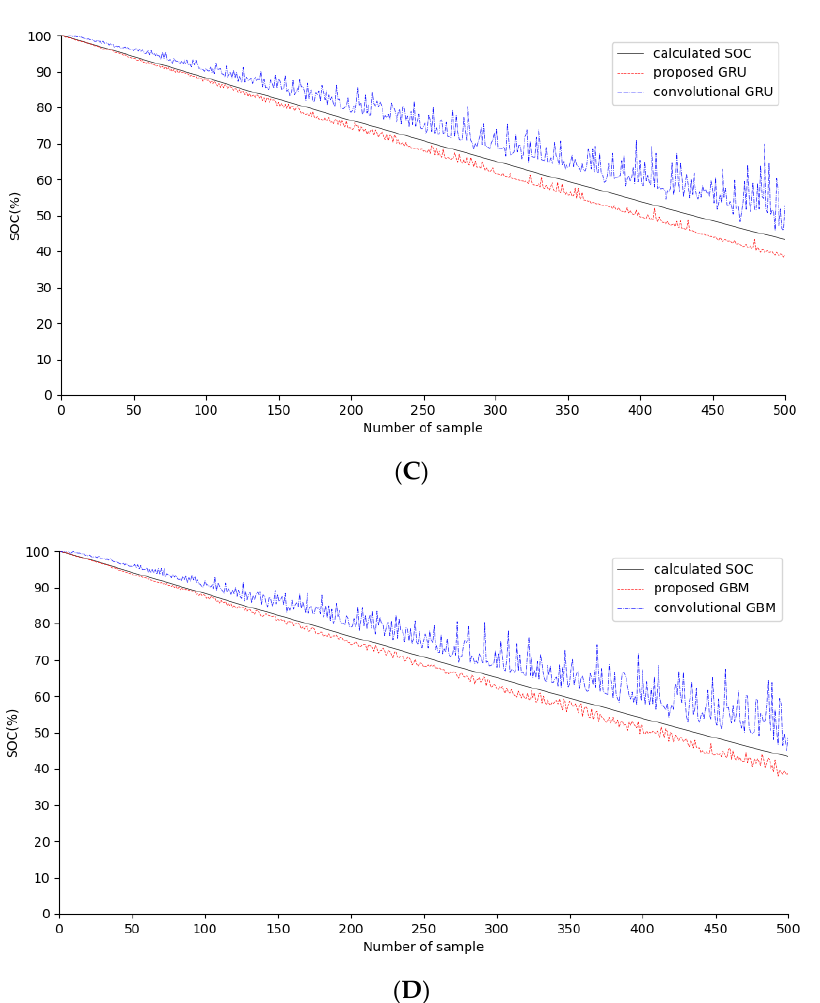
Figure 12. ( A ) The SOC-estimation results for the MNN using the proposed and conventional methods; ( B ) the SOC-estimation results for the LSTM using the proposed and conventional methods; ( C ) the SOC-estimation results for the GRU using the proposed and conventional methods; ( D ) the SOC-estimation results for the GBM using the proposed and conventional methods. Table 3. Hyperparameters of the LSTM for SOC estimation.